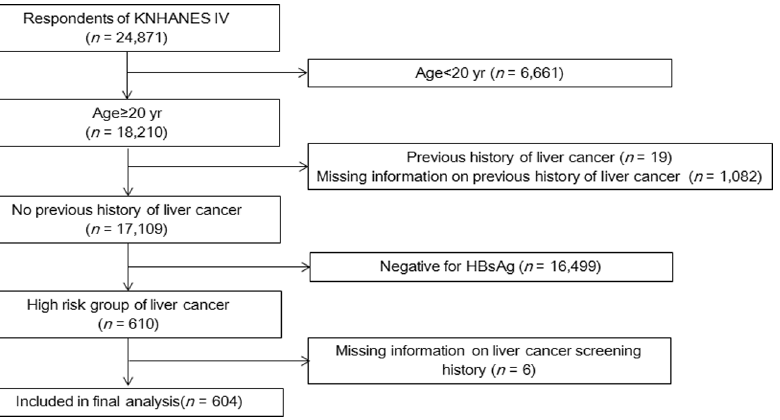
Figure 1. Flowchart of the study population. KNHANES IV (fourth Korean National Health and Nutrition Examination Surveys), HBsAg (hepatitis B surface antigen), and HCV(hepatitis C virus).